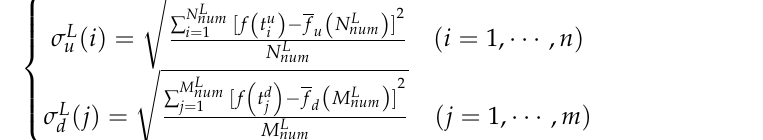
where L denotes the positive direction. The average values of the local maximum and minimum sequences are represented by 𝑓(cid:4636) (cid:3048) (cid:4666)𝑁 (cid:3041)(cid:3048)(cid:3040)(cid:3013) (cid:4667) and 𝑓(cid:4636) (cid:3031) (cid:4666)𝑀 (cid:3041)(cid:3048)(cid:3040)(cid:3013) (cid:4667) , which are calculated using Equation (3).